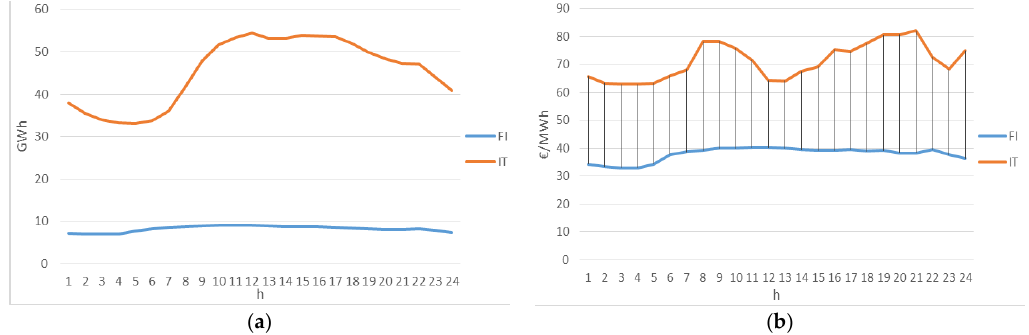
Figure 30. ( a ) Electricity demand trends and ( b ) market prices recorded on the 26 July 2013 for Italy and Finland.